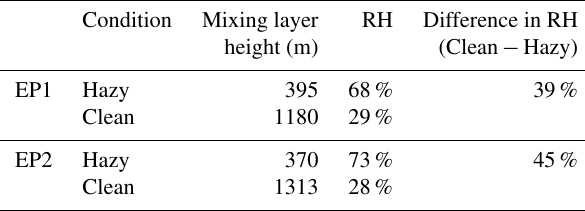
Figure 6. Temporal evolutions of surface temperatures (a, c) and 10m wind speeds (b, d) under the clean conditions (blue solid) and the polluted conditions for the non-BC (red dot), fresh-BC (red dashed), and aged-BC (red solid) cases. Panels (a) and (b) corre- spond to EP1, and (c) and (d) correspond to EP2. Table 3. RH sensitivity to PBL height changes calculated using the empirical equations by Tie et al. (2017). PBL heights are from ceilometer